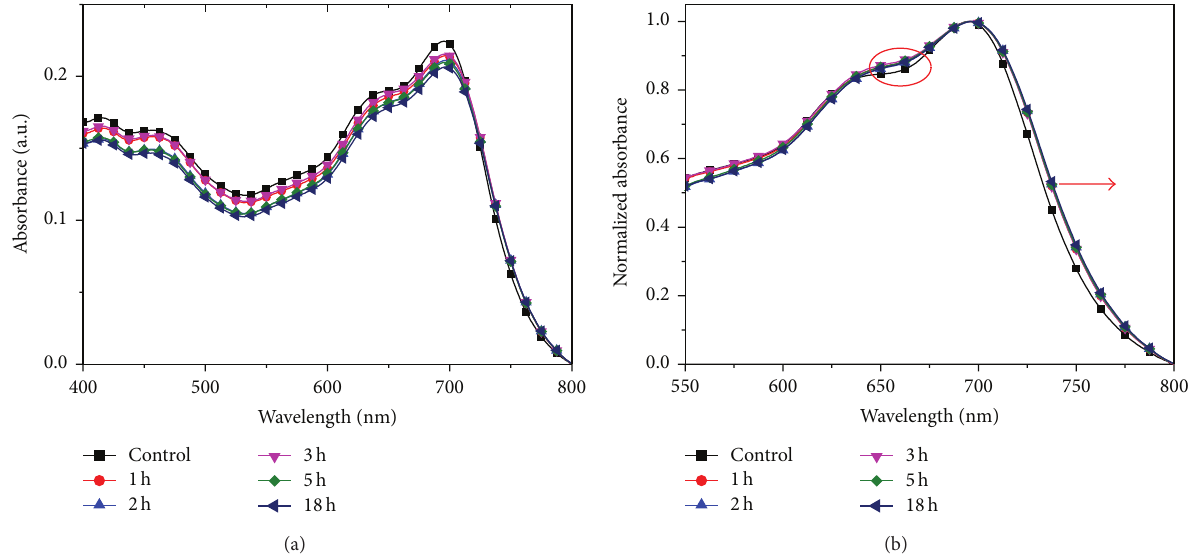
Figure 7: Absorption spectra of the (a) inverted solar cells and the normalized absorption spectra of (b) inverted solar cells treated at 70 ∘ C for different